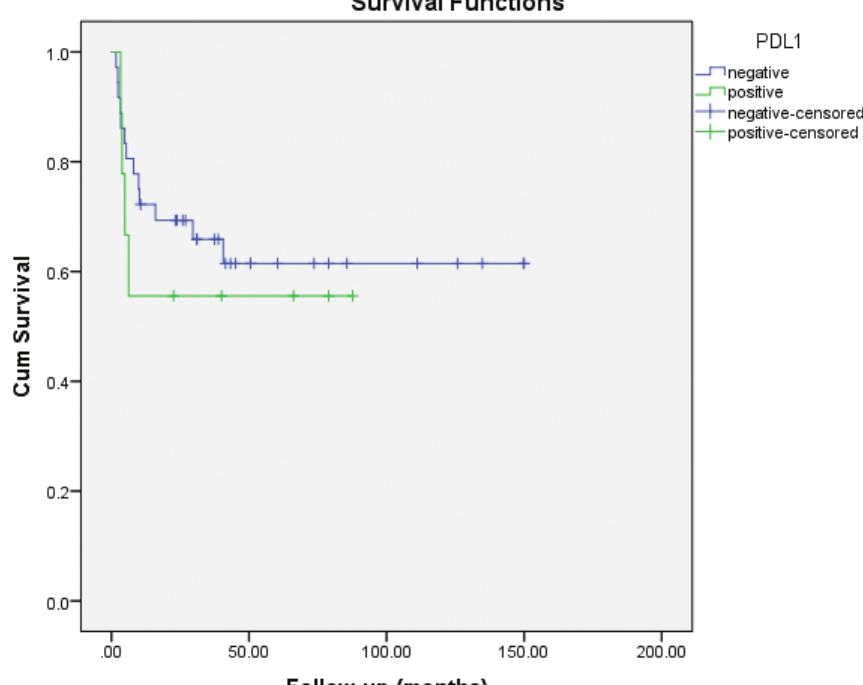
Figure 3. Kaplan–Meier plots of recurrence-free survival (RFS) according to PD-L1 expression status in non-ccRCC